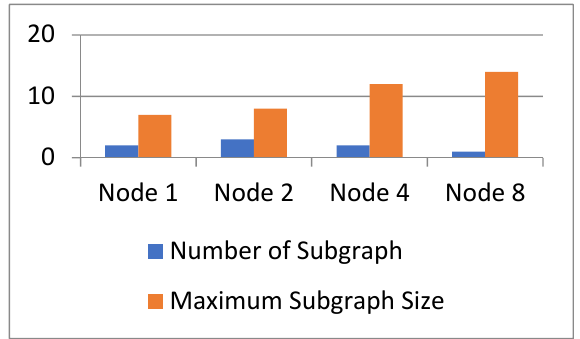
Figure 6. Changes in connectivity.